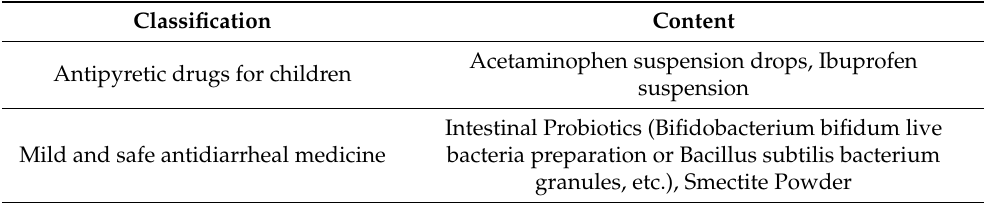
Table 4. List of supplemental stockpile drugs for families with children.